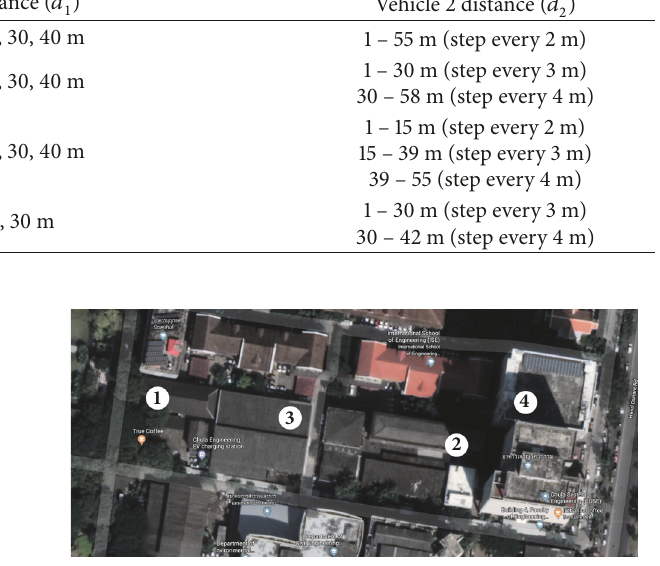
Figure 8: The bird’s eye view of the blind corners in our experiment. (1) Electrical Engineering lab. (2) Mechanical Engineering Lab. (3) Civil Engineering Lab. (4) Centennial Building.